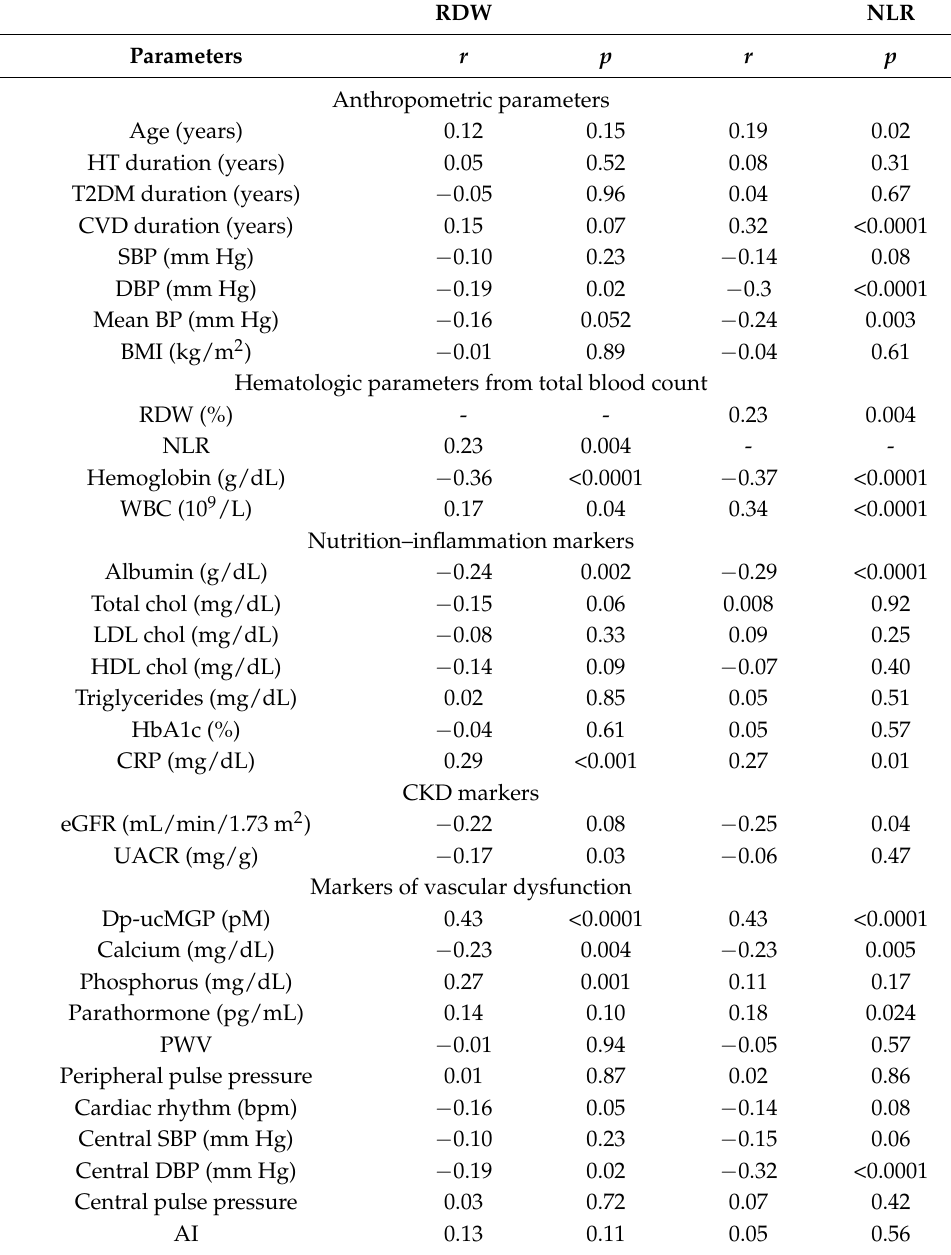
Table 2. Correlations of various parameters with RDW and